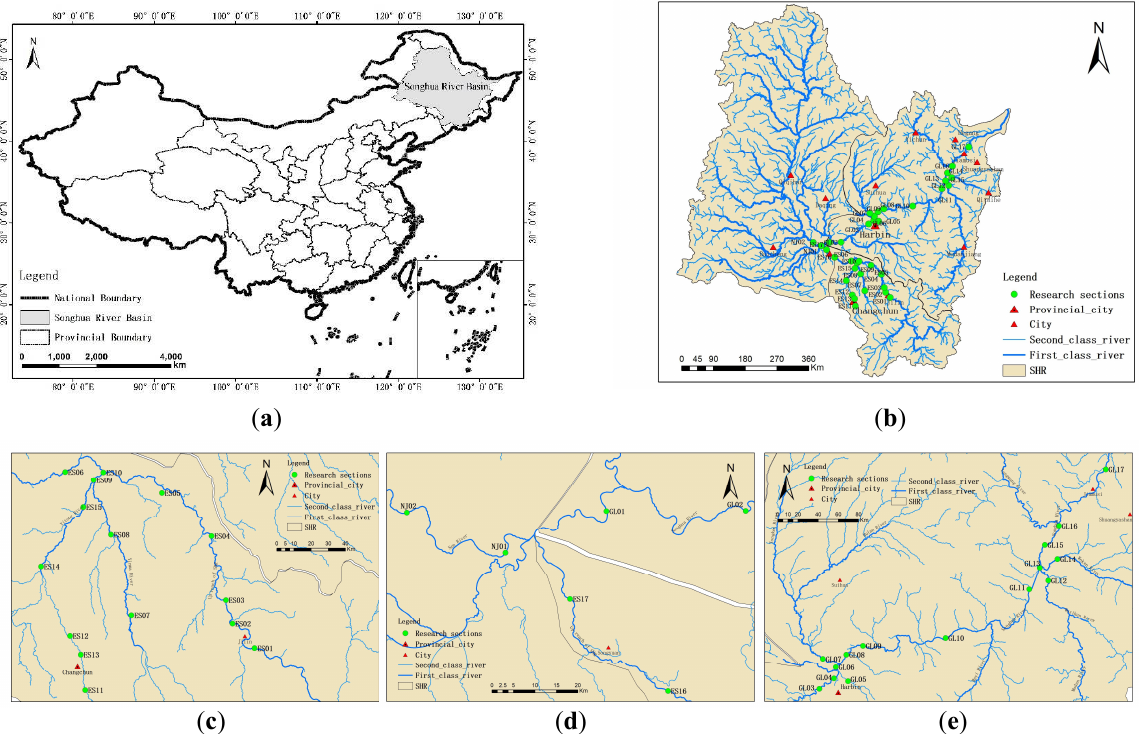
Figure 1. Sampling sections diagram. ( a ) Location of the SHR in China. ( b ) General sampling sections of the SHR. ( c ) Sampling sections the Jilin–Changchun river reach. ( d ) Sampling sections of in the confluence area of three rivers. ( e ) Sampling sections of the Harbin–Jiamusi river